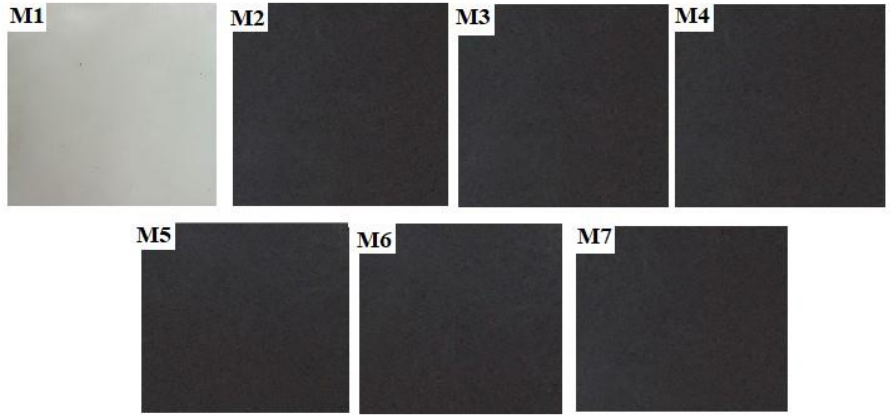
Figure 2. Digital images of the prepared nanocomposites sheets of HDPE/CNTs samples ( M1 – M7 ).